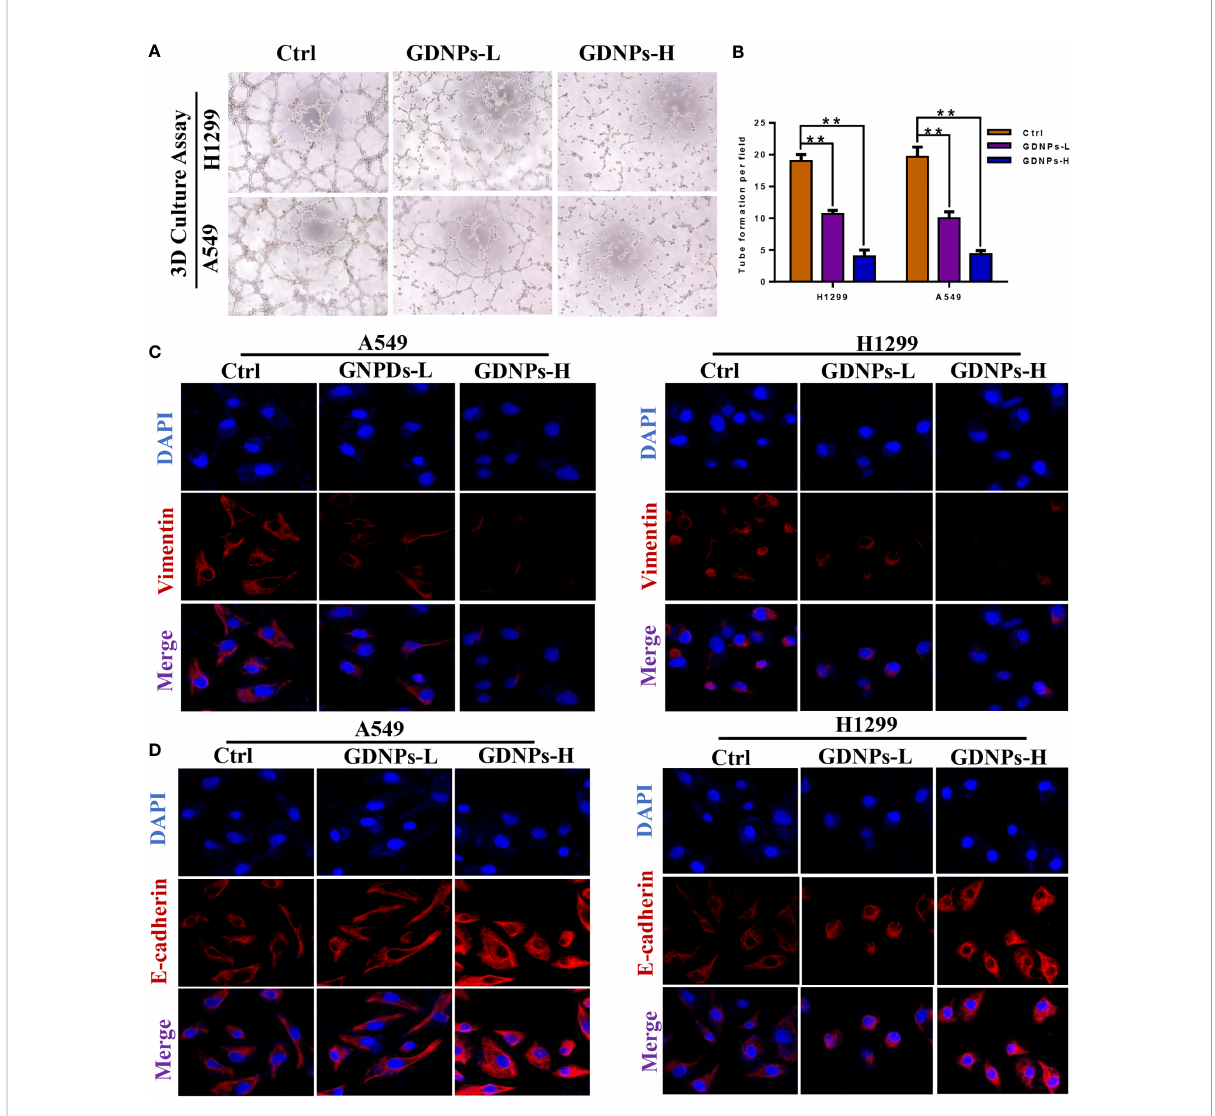
FIGURE 4 GDNPs treatment inhibited VM formation and reversed EMT biomarker changes. (A, B) Tube formation revealing decreased VM formation following GDNPs treatment, with statistical results summarized in panels to the right (C, D) Immuno fl uorescence assays revealed increased E- cadherin expression and decreased vimentin expression as compared with untreated group cells. Data are presented as the mean ± SD of three experiments (*P <